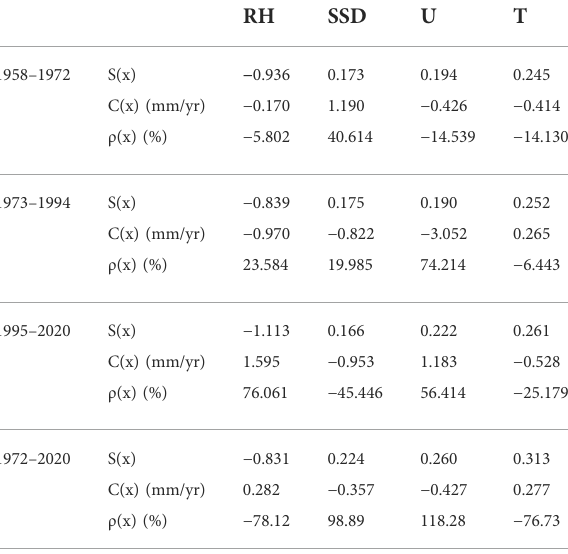
TABLE 2 The sensitivity coef fi cients (S(x)), contributions (C(x)), and proportional contributions ( ρ (x)) in the different